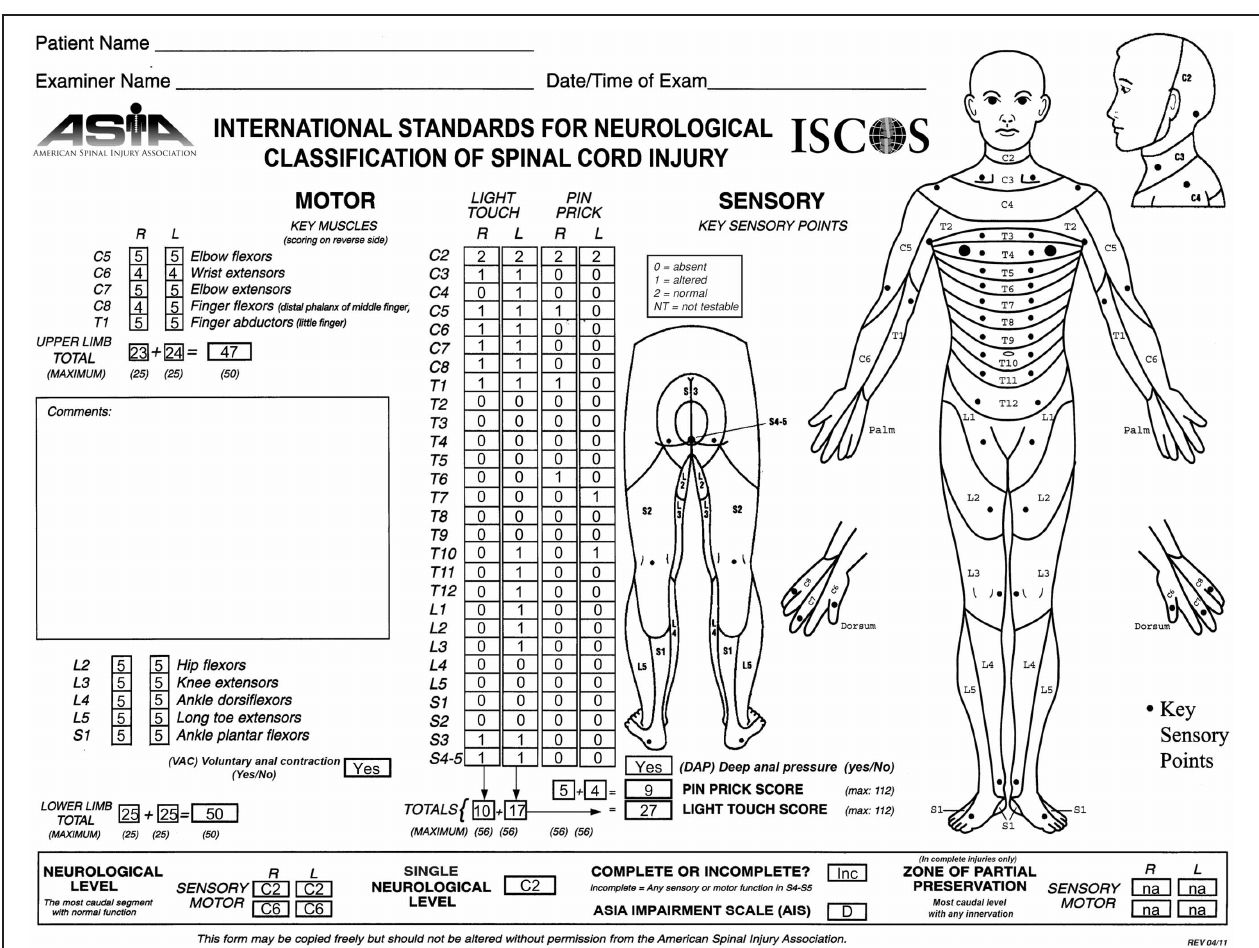
FIGURE 1 | ASIA classification of the patient after recovery, performed according to the International Standards for Neurological Classification.